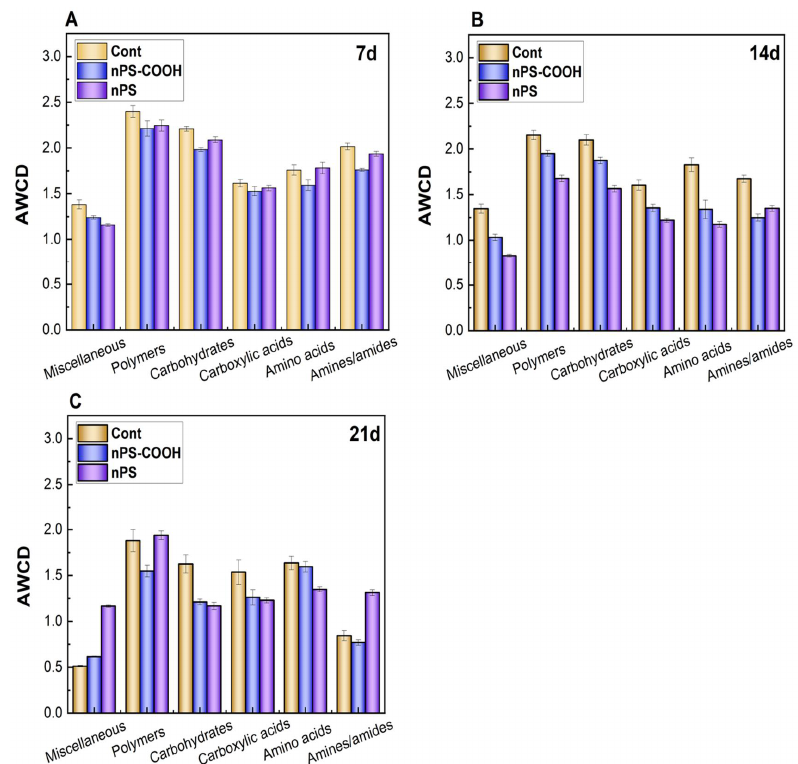
Figure 5. The metabolism capacity of the six biochemical categories carbon of biofilms (at the stable stage) exposed to PS NPs with different surface modifications at day 7 ( A ), day 14 ( B ), and day 21 ( C ) ( n = 3).